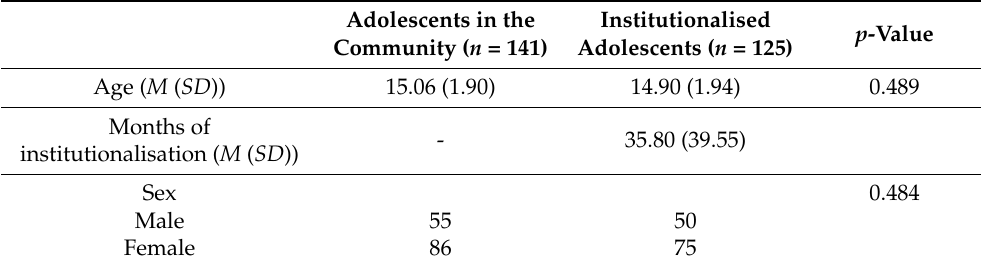
Table 1. Sociodemographic characteristics of the participants ( n =